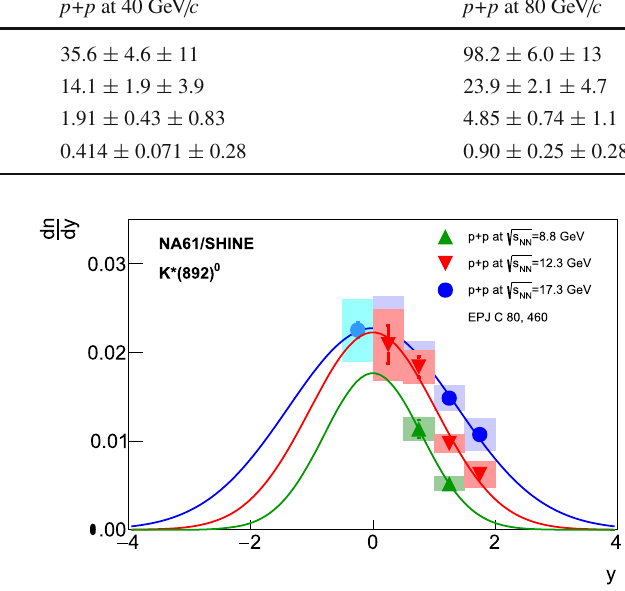
Fig. 8 Therapidityspectra dn of K ∗ ( 892 ) 0 mesonsproducedininelas- dy tic p+p collisions at 40 GeV / c and 80 GeV / c in transverse momentum range 0 < p T < 1 . 5 GeV / c . The numerical values are listed in Table 7. The solid lines represent the function given by Eq. (13). For comparison the previous NA61/SHINE results [9] for p+p interactions at 158 GeV / c are also shown (they were obtained in the full transverse momentum range; p T -integratedandextrapolatedrapidityspectrum).For158GeV / c the first (light blue) point ( y < 0) was not included in the fit (see